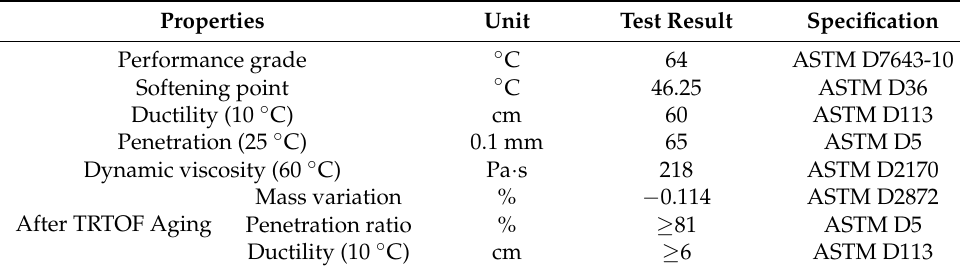
Table 1. Properties of base asphalt binder.